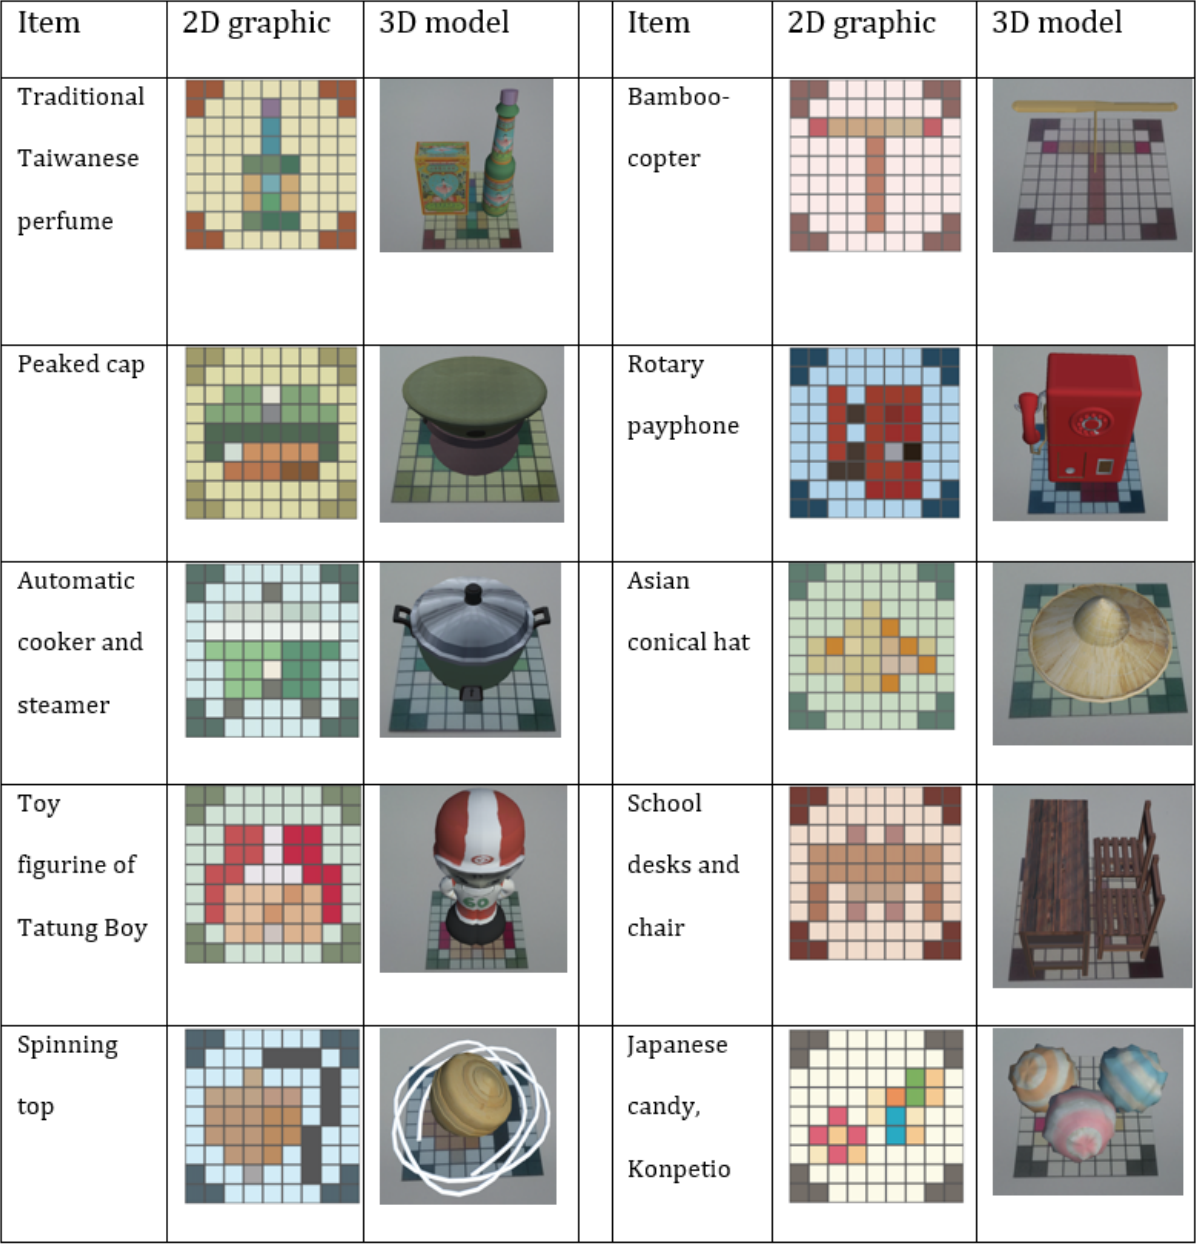
small square tile, the rectangle tile, the L -shaped tile, and the large square tile. Each puzzle tile includes part of the 2D pixel graphic for one or more of the nostalgic objects, so the players have to put the puzzle tiles together to construct the complete 2D pixel image of a nostalgic object (Figure